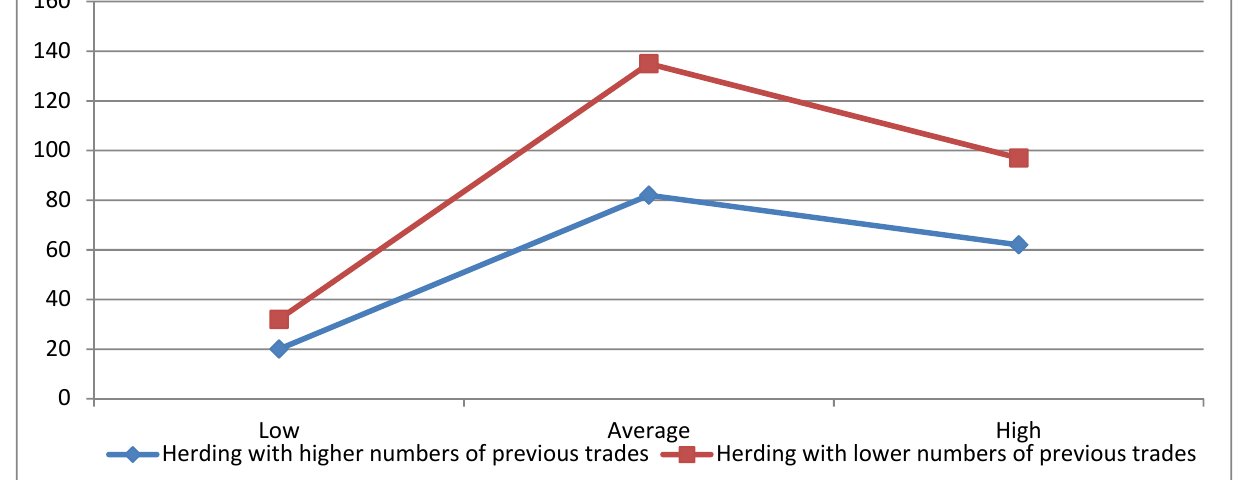
Fig. 1. Herding with lower versus higher numbers of previous